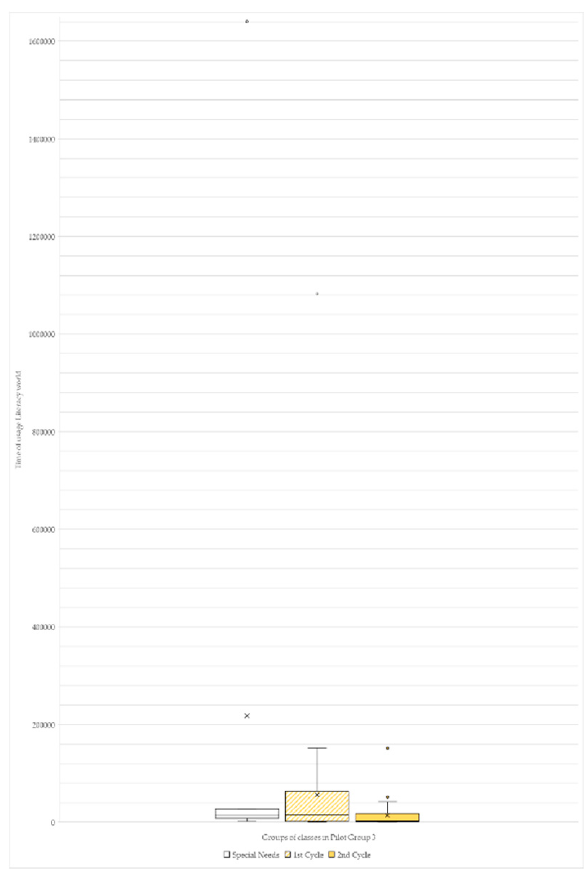
Figure 9. Descriptive statistic representation of significant results via one-way ANOVA analysis, showing the relationships between the number of activities played in the Literacy world per class groups.